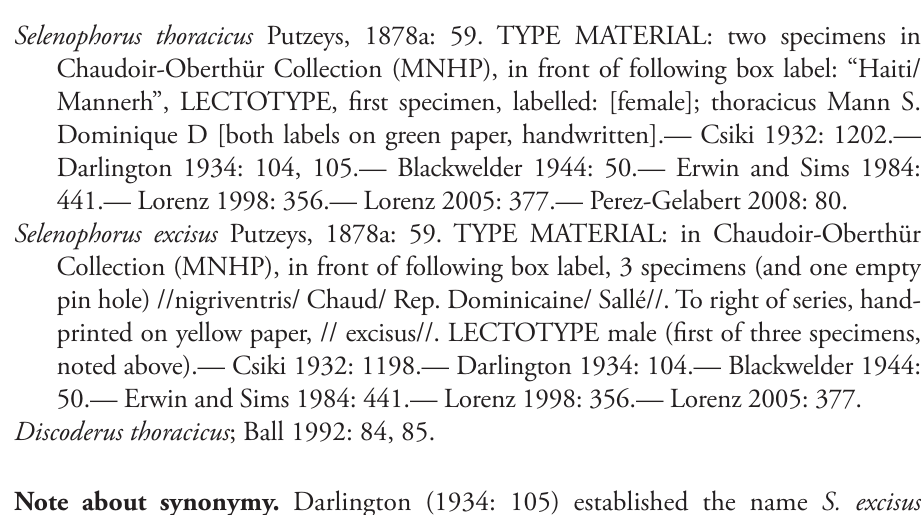
Discoderus thoracicus (Putzeys) Figs 66D, 68D–F, 69D,